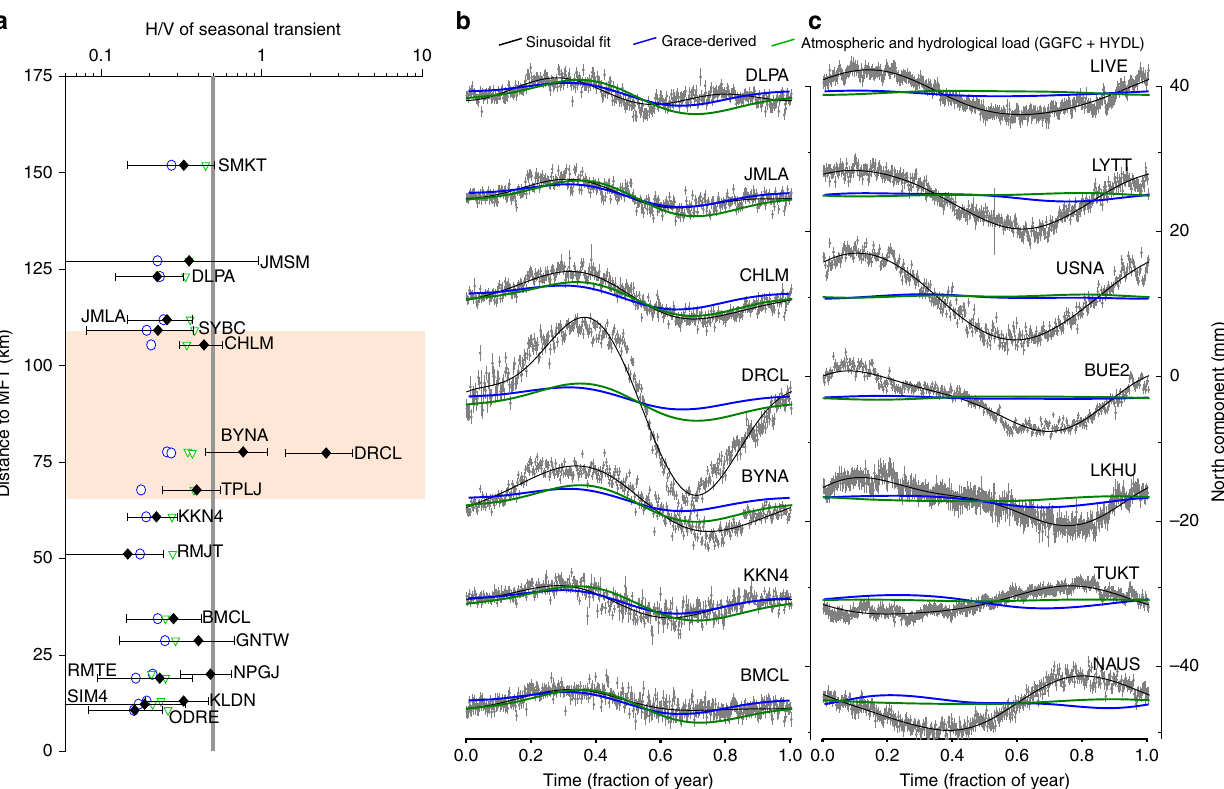
Fig. 2 Measured annual signals and modelled surface loading contribution. a Ratios of mean amplitudes of horizontal over vertical annual signals (H/V ratio) with distance to the Main Frontal Thrust (MFT) for Global Navigation Satellite Systems (GNSS) observations (see Data Availability) in Nepal (black diamonds), Gravity and Recovery Climate Experiment (GRACE) derived loading model (blue contoured dots; Chanard et al. 4 ) and the sum of HYDL (hydrological loading model) and GGFC (see Data Availability) (Global Geophysical Fluid Centre) atmospheric loading (green contoured triangles). Mean annual peak to peak seasonal amplitudes and associated error bars have been estimated using the coordinate time series analysis software, CATS (see Data Availability), and combined in H/V ratio. The amplitudes of annual and semi-annual sinusoidal signals are estimated together with white and fl icker noise from detrended time-series. b , c GNSS time series stacked over a year (grey dots and associated error bars), with corresponding sinusoidal fi t (plain black), GRACE-derived model (plain blue) and the sum of HYDL hydrological loading model and GGFC (see Data Availability) atmospheric loading (plain green), models for Nepal ( b ) and a set of globally distributed International GNSS Service (IGS) stations (see Fig. 1, IGS, repro2) ( c